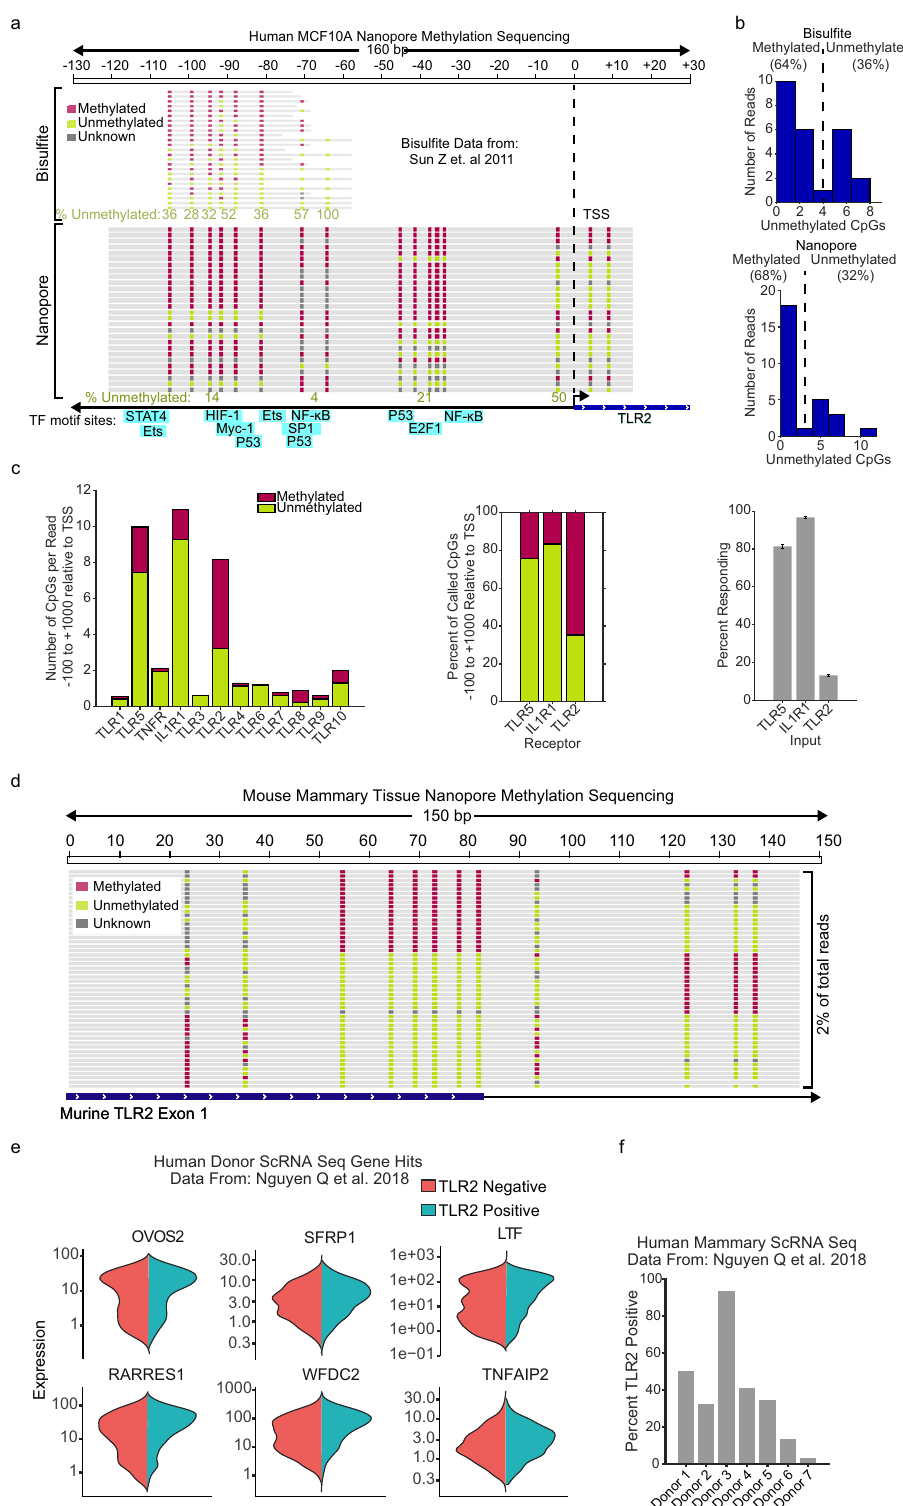
Fig. 5 TLR2 promoter methylation is bimodal. a Bisul fi te 36 and nanopore sequencing data of 130 bp upstream of the TLR2 transcription start site (TSS) in MCF10A. Locations of transcription factor consensus binding sequence sites are indicated. b Histogram quanti fi cations of the number of unmethylated CpGs per read between − 110 and − 60. c Nanopore methylation sequencing 57 data of 100 bp upstream to 1000 bp downstream of TSS for indicated receptor. Percentage of unmethylated and methylated CpGs as well as percent responding cells as determined by p65 immuno fl uorescence following TLR5 (Flagellin), IL1R (IL-1B), and TLR2 (Pam) stimulation. d TLR2 locus targeted nanopore sequencing of genomic DNA isolated from primary mouse epithelial mammary cells. e Differentially expressed genes cosegregating with TLR2 negative and positive cells in publicly available single-cell RNA sequencing data from human breast epithelial tissues 40 . f Percent TLR2 positive cells from ScRNA sequencing data collected from breast tissue of seven female donors. Only cells expressing luminal expression markers were considered (see Methods section for